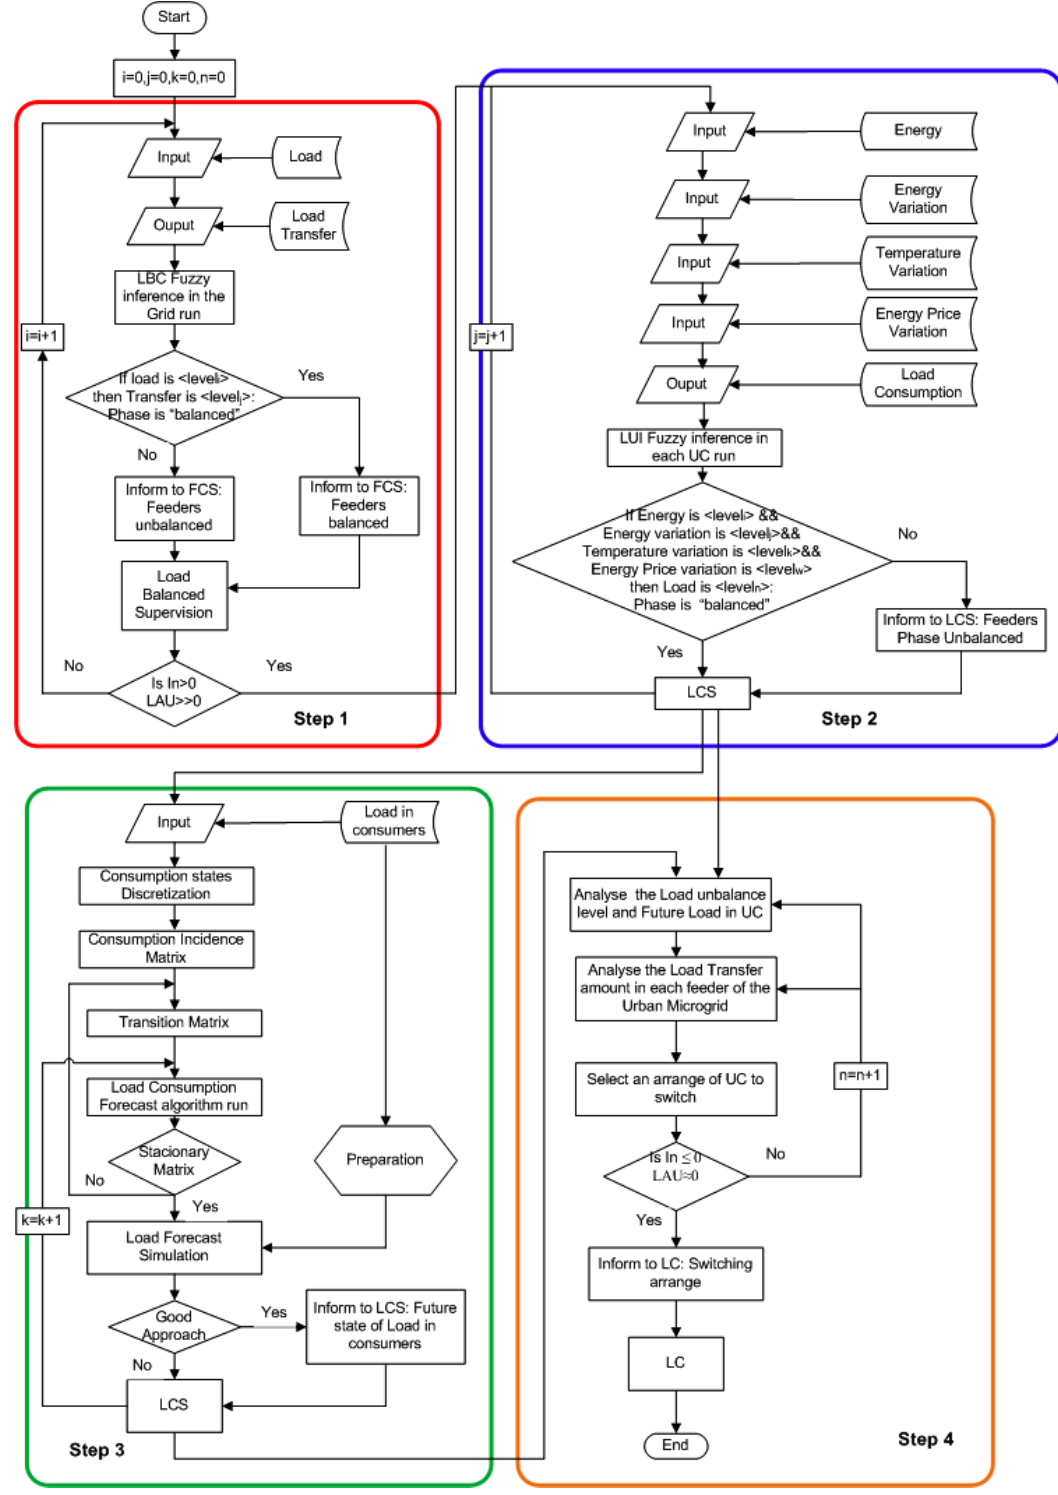
Figure 5. Combined algorithms flowchart of the LBC